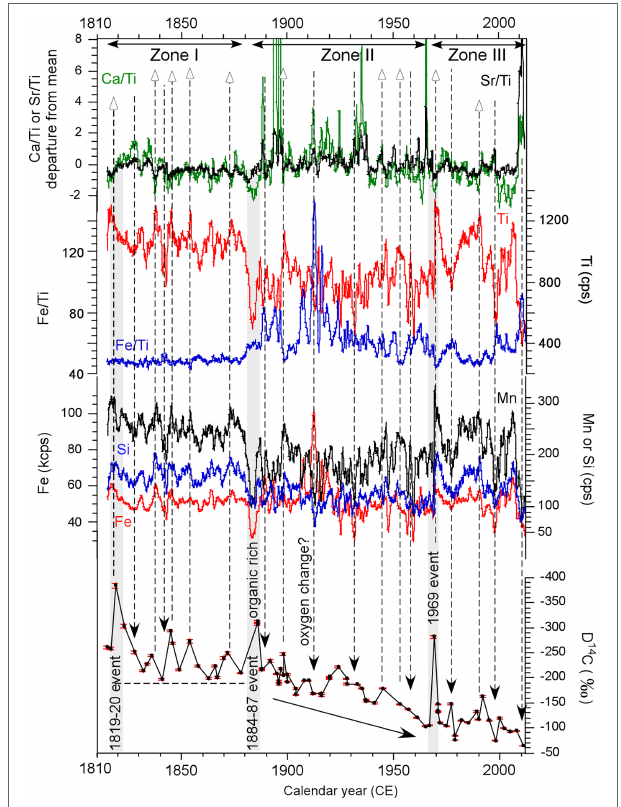
FIGURE 5 | Comparison of the variations in D 14 C TOC values and the scanning XRF elemental contents in Core SBB-8-2012. In general, more depleted D 14 C value corresponds to higher siliciclastic elements (K, Ti, Si, Mn and Rb) and lower biogenic proxies (Ca/Ti, Sr/Ti and Fe/Ti); and vice versa. The dashed vertical lines with open arrow refer the periods of more depleted D 14 C value, whereas the dashed vertical lines with solid arrow show the intervals with less depleted D 14 C